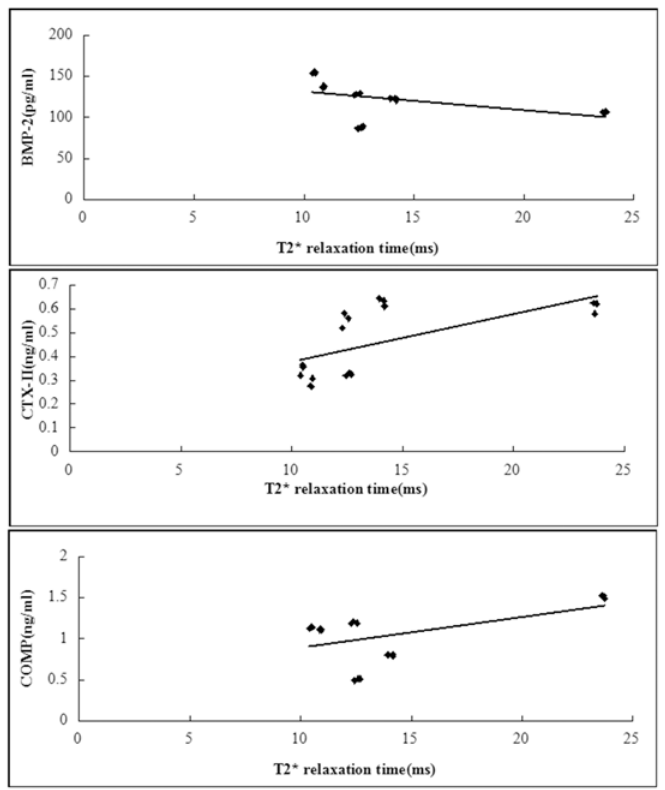
Fig 13. Scattergrams plotting individual serum biomarker concentration against T2 * relaxation time values. T2 * relaxation times correlated significantly with BMP-2, CTX-II and COMP (D, R 2 = 0.23, P = 0.043; E, R 2 = 0.4, P = 0.005; F, R 2 = 0.28, P = 0.025). N =